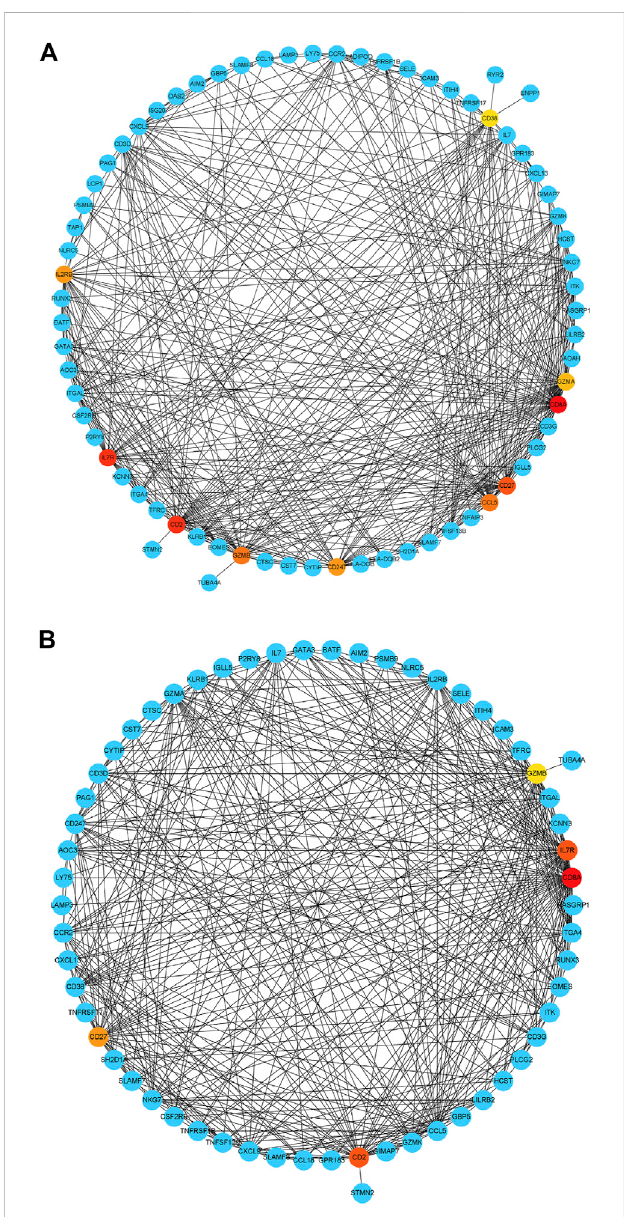
FIGURE 4 DetectionofhubgenesfromthePPIsnetworkofDEGsbetweenRA and OA according to their degree value. (A) The highlighted fi ve genes are CD8A , GZMB , CCL5 , CD2, and CXCL9 in RA-LJ samples compared with OA samples (B) The highlighted fi ve genes are CD8A , CD2 , IL7R , CD27 , and GZMB in RA-SJ samples compared with OA samples. Red, orange and yellow modules represent hub genes, and the degree valuesofhubgenesdecreasefromredtoyellowmodules.Bluemodules refer to the genes which can interact with hub